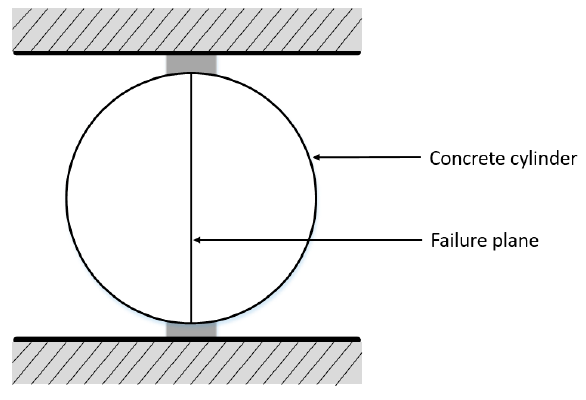
Figure 1. Specimen arrangement of splitting test [22].